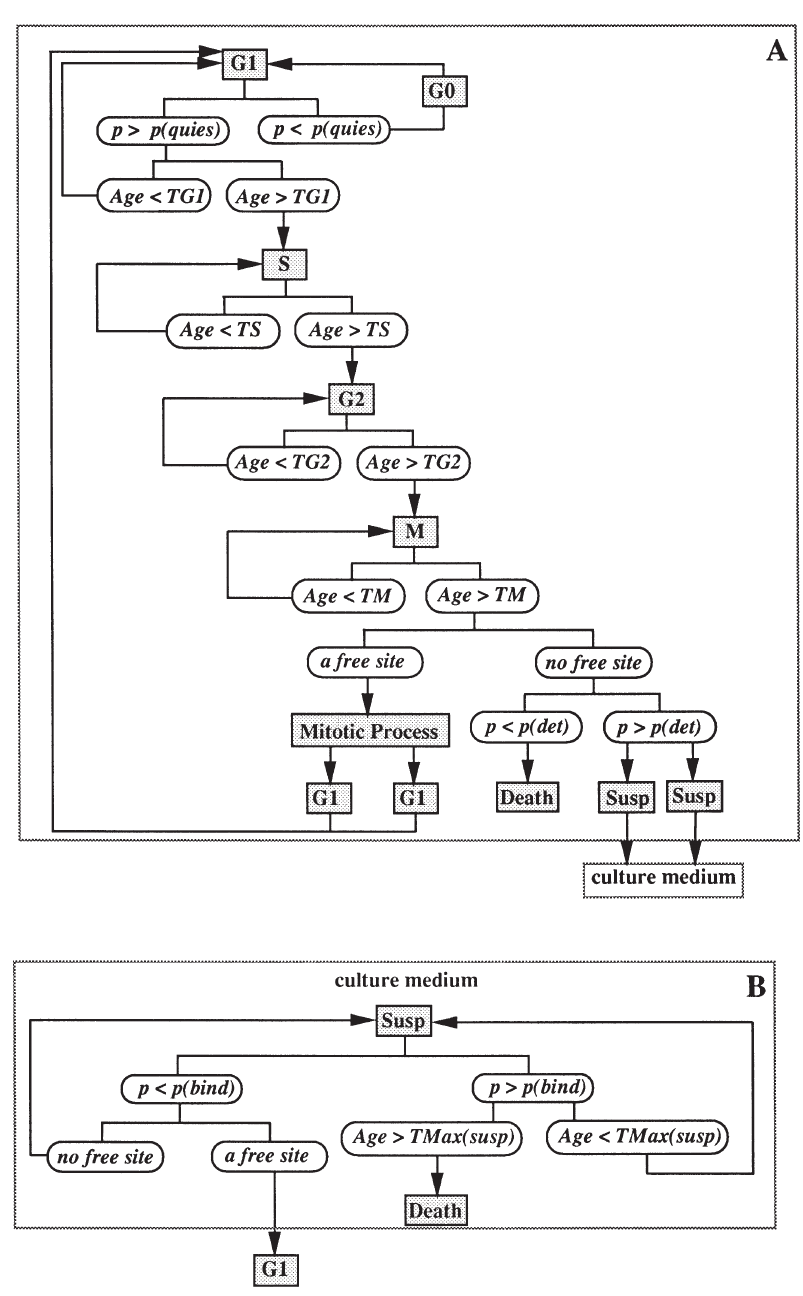
Fig. 4. Flow chart of the simulation procedure. A: grid cells management. During its proliferation, a cell passes the distinct , T S , T G and T M are normally distributed. At any time of the cell cycle phases G 1 , S, G 2 and M. The phase durations, T G 1 2 G 1 phase a cell is able to enter the resting phase G 0 with a probability p (quies). When division occurs, one daughter cell stays on the original site and the other will be put on one of its neighbouring free sites. If there is no free site, the daughter cell may detach from the grid with a probability p (det). B: culture medium cells management. A cell in the culture medium is able to bind a free site on the grid with a probability p (bind). The time during which a cell remains in the culture medium is limited to T max